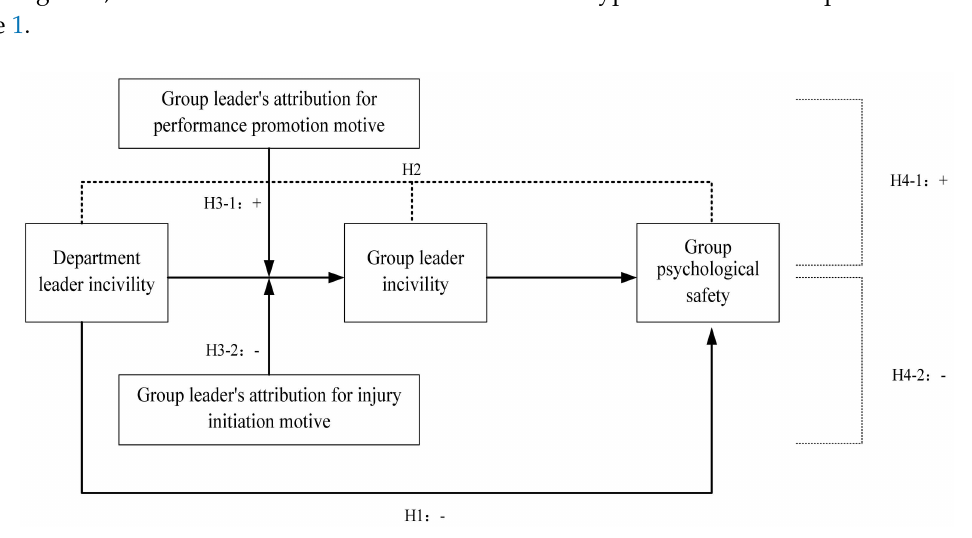
Figure 1. The research conceptual